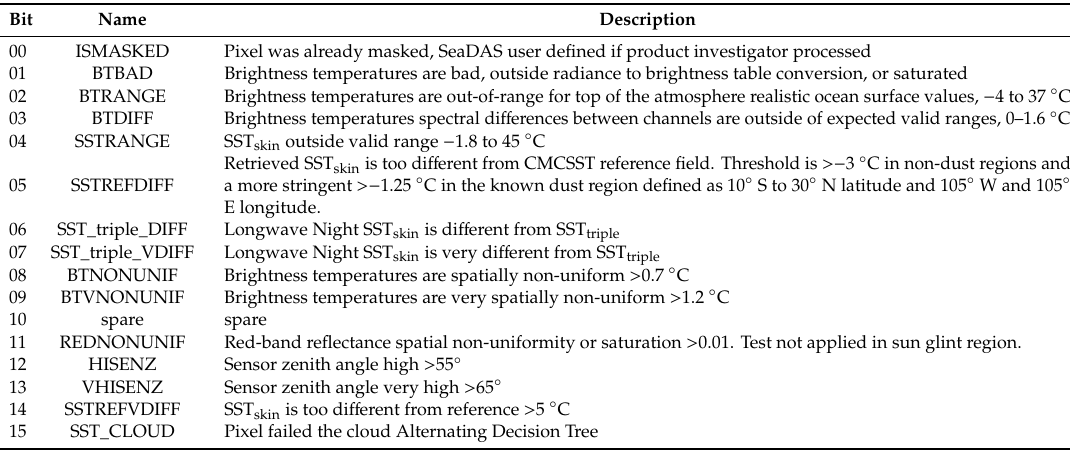
Table A1. Quality level flags.